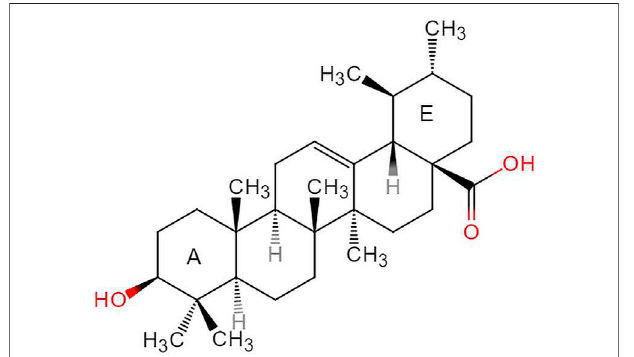
FIGURE 3 | The mechanism of the EPR effect. The EPR effect, which refers to the high permeability of tumor blood vessels and the absence of lymphatic re fl ux, promotesahighaccumulationofnanoformulationsintumortissue(comparedtonormaltissue).Duetotherapidgrowthoftumorcells,thevascularendotheliumoftumor tissue isdamaged. The vascular endothelium gaps in tumor tissue are wider than that in normal tissue, and thus has higher permeability, which isconducive to the entry of nanoformulations into tumor tissue. Moreover, the lymphatic system in the tumor tissue is damaged and cannot play an effective fi ltering and clearing role as the normal lymphatic system, so that the nanoformulations are retained in the vicinity of the tumor and released slowly, which improves the targeting performance of nanoformulations. Abbreviations: The EPR effect, the enhanced permeability and retention effect.